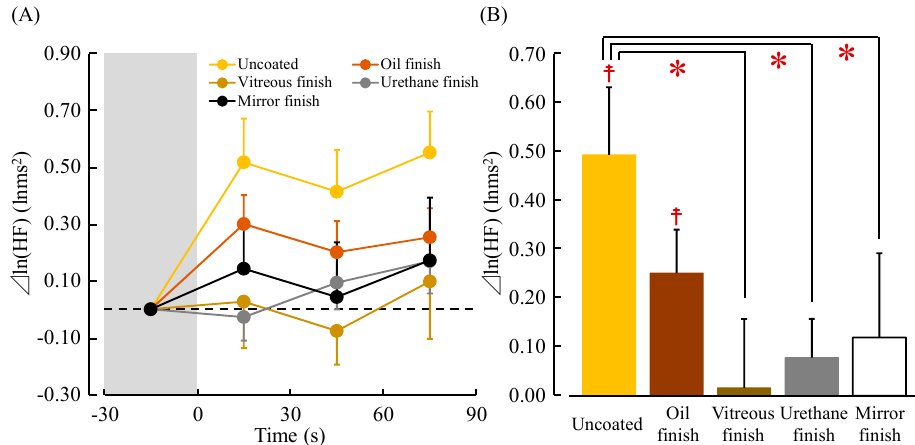
Figure 6. Thirty-second averages and overall mean of the natural logarithm of the HF component of HRV while touching white oak wood (uncoated, oil finish, vitreous finish, urethane finish, and mirror finish). ( A ) Changes in each 30-s average HF value over 90 s; ( B ) Overall mean HF values. Data are expressed as mean ± standard error, n = 18, ☨ p < 0.05 (comparing pre- vs. post-measurement values), applied.